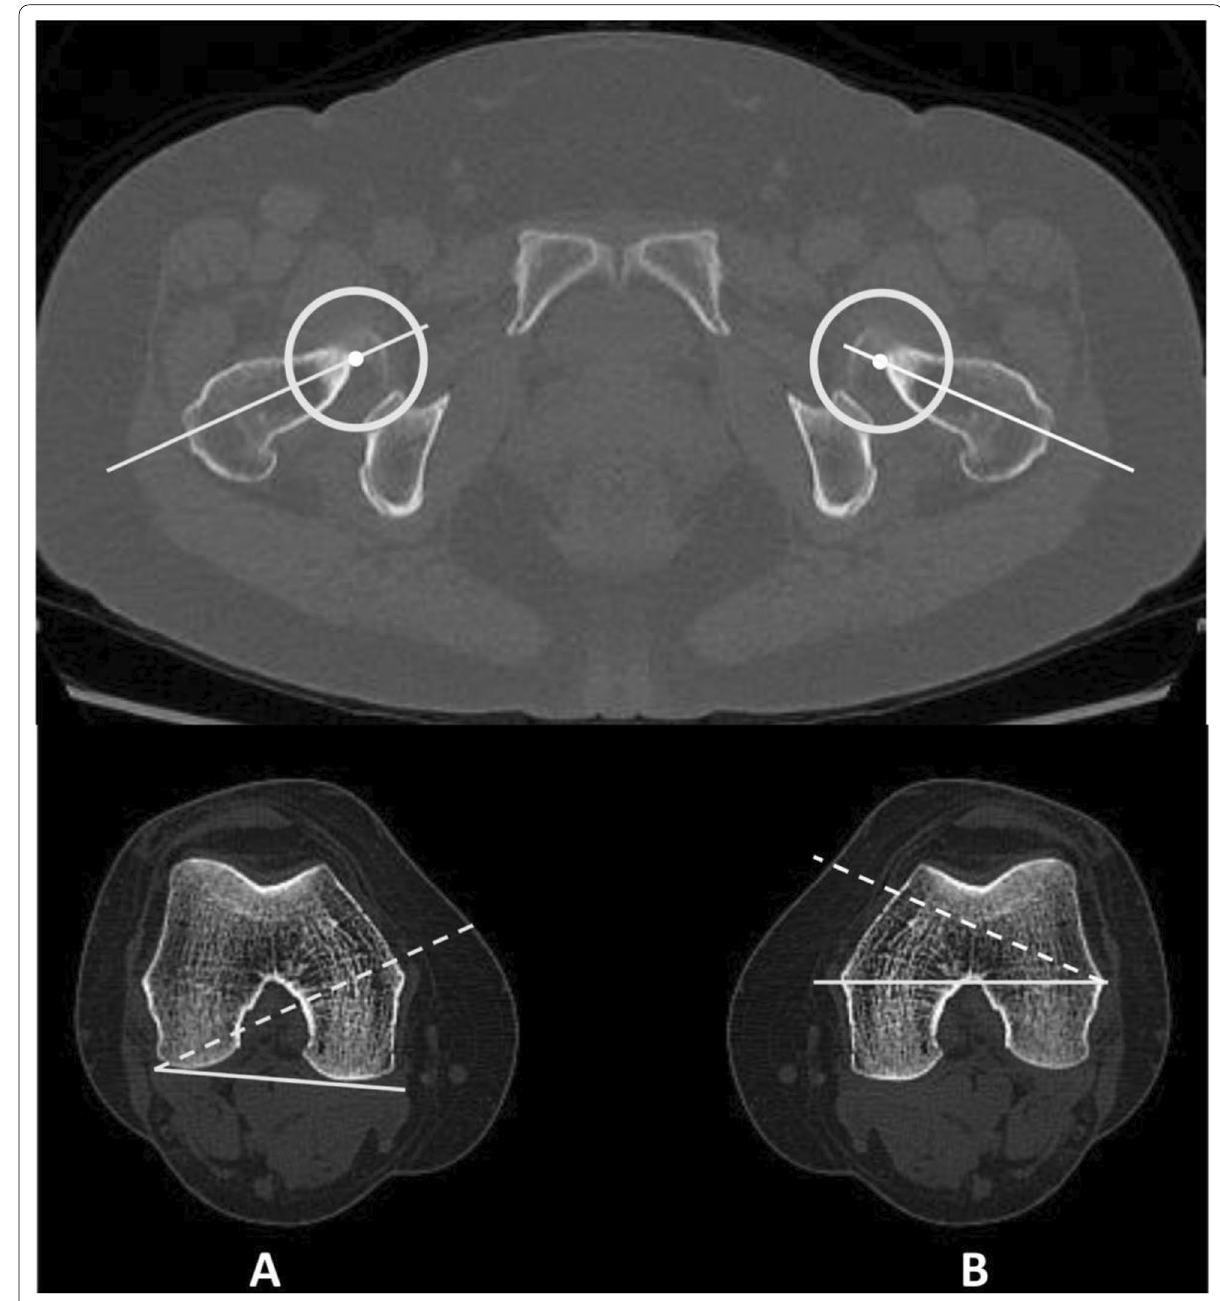
Fig. 2 Measurements of the FA using two methods: A pFA (angle formed between the lines intersecting the femoral neck axis and the PCL); B tFA (angle formed between the lines intersecting the femoral neck axis and the TEA). Positive values indicate femoral